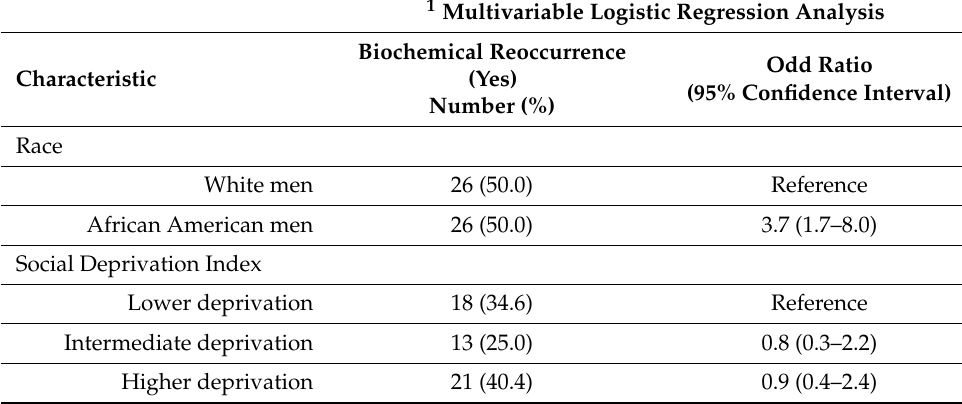
Table 4. Multivariate logistic regression model of biochemical